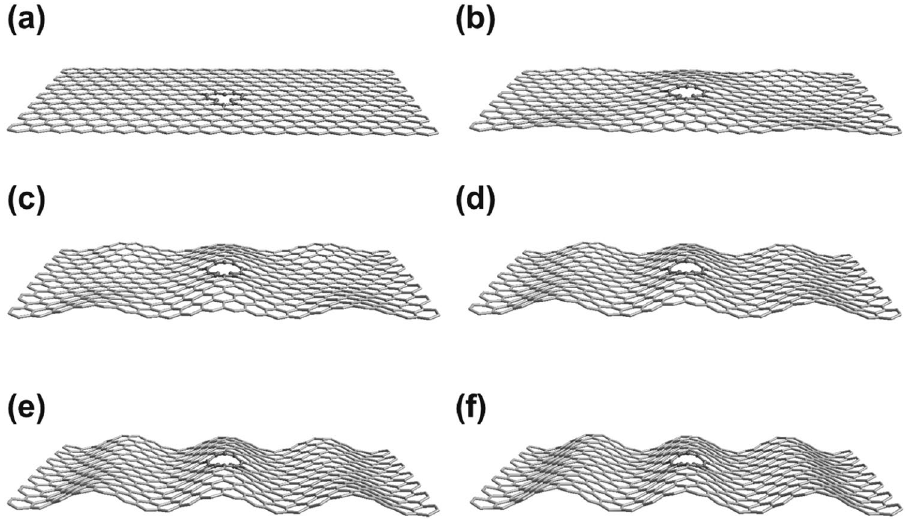
Figure 3. The optimized geometries of a single vacancy in graphene under shear distortion. ( a )–( f ) For Δ θ = 0°–5°,